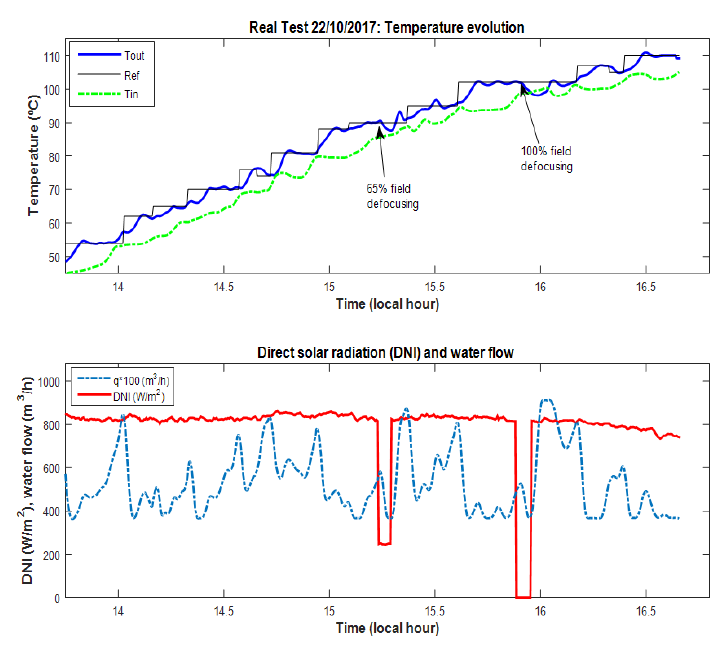
Figure 17. Real Test carried out on 22 October